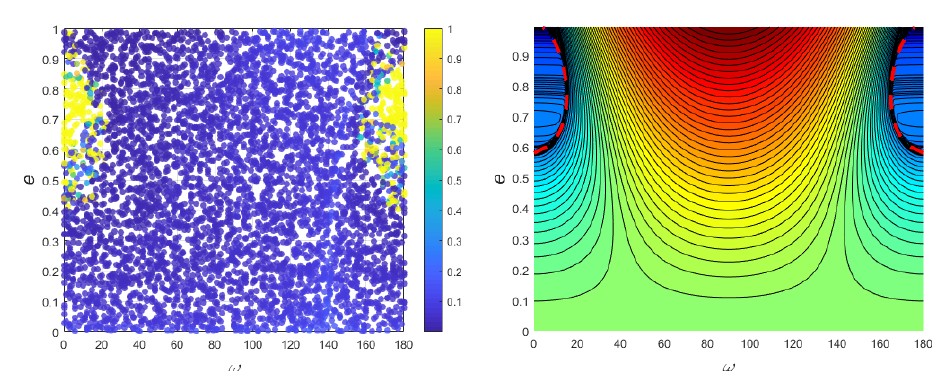
Figure 6. Pure secular dynamics of polar orbits outside the 2/1 resonance. ( Left panel): The lifetime ratio of the 5000 particles in numerical integrations. ( Right panel): Phase-space portrait of pure secular dynamics. The levels of Hamiltonian in Equation (7) are plotted on e − ω plane. The thick black dashed lines denote collision curves with the